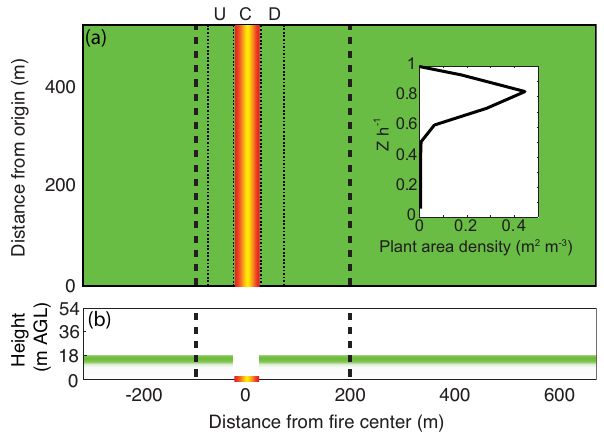
Figure 1. Experiment design summary, with (a) planview and (b) vertical cross-section depictions of canopy and fire. In panel (a) , forest is depicted with green shading and surface heat flux in fire strip is shaded from red (weakest) → yellow (strongest). Fire strip is divided into three zones – upstream, center, and downstream – with three gap cases considered: gap in the upstream zone (UG), gap in the center zone (CG), and gap in the downstream zone (DG). Inset panel in panel (a) depicts the plant area density profile ap- plied at all forested points; canopy height ( h ) = 18m. In panel (b) , a vertical cross section of plant area density in the x – z plane is pro- vided for case CG, along with the location of the surface fire. Thick dashed lines denote the portion of the domain displayed in subse- quent